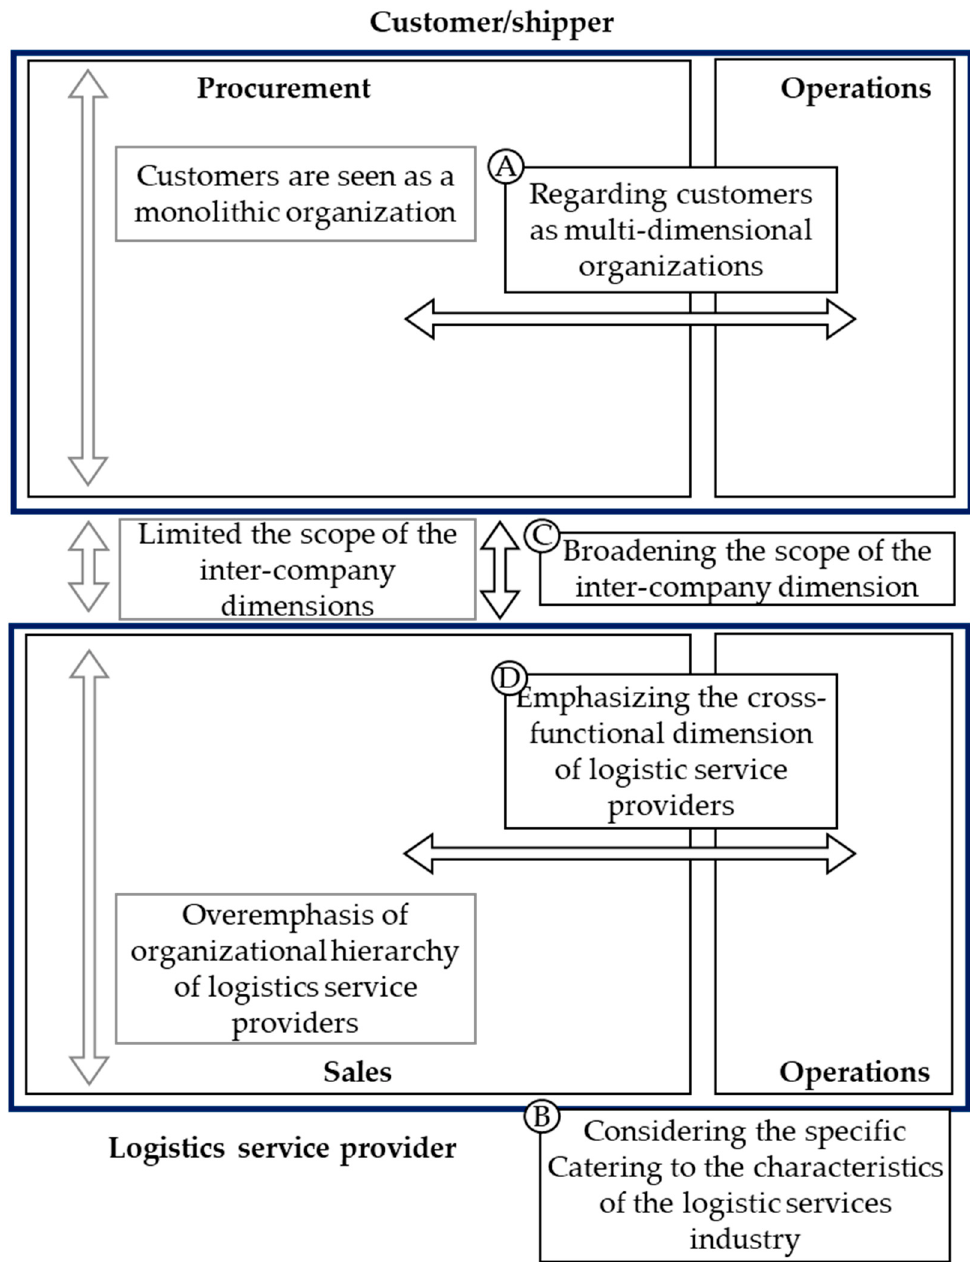
Figure 3. Necessary extensions to the traditional service quality model.